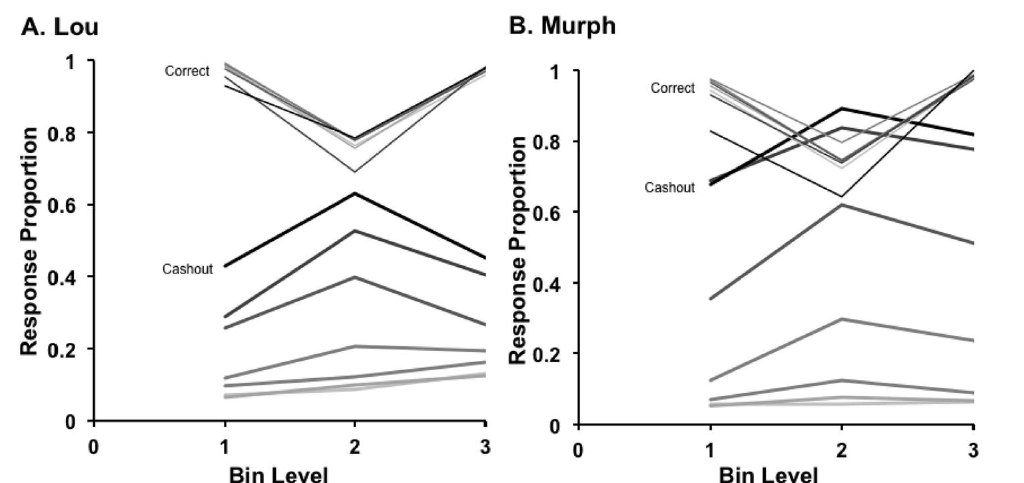
Figure 3 . Results from monkeys ( A ) Lou and ( B ) Murph in a task with variable numbers of rewards at risk and the need to make a density discrimination. Bin 1 includes the sparsest trials; Bin 2 includes trials that are intermediate between sparse and dense; Bin 3 includes the densest trials. The peaked curves show the proportion of all trials at each bin level receiving the cashout response, which allowed monkeys to collect accumulated rewards before they had to make the density discrimination. The troughed curves show the proportion of correct responses (for all trials completed directly without cashing out). For both cashout responses and proportion correct, progressively darker lines depict increasingly risky situations in which there were more coins/rewards at stake. Reprinted from “Cashing Out: The Decisional Flexibility of Uncertainty Responses in Rhesus Macaques ( Macaca mulatta ) and Humans ( Homo sapiens ),” by A. C. Zakrzewski, B. M. Perdue, M. J. Beran, B. A. Church, and J.